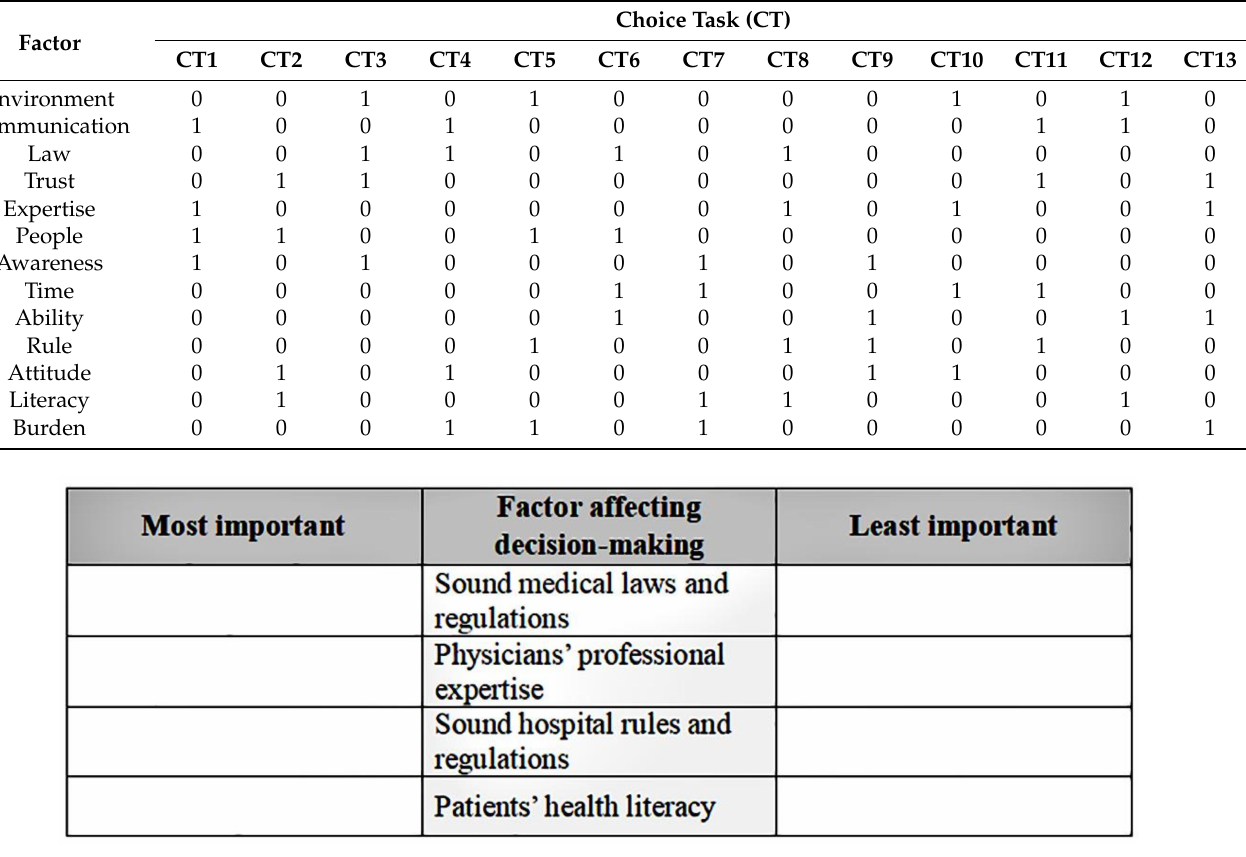
Figure 1. An example of the best-worst scaling